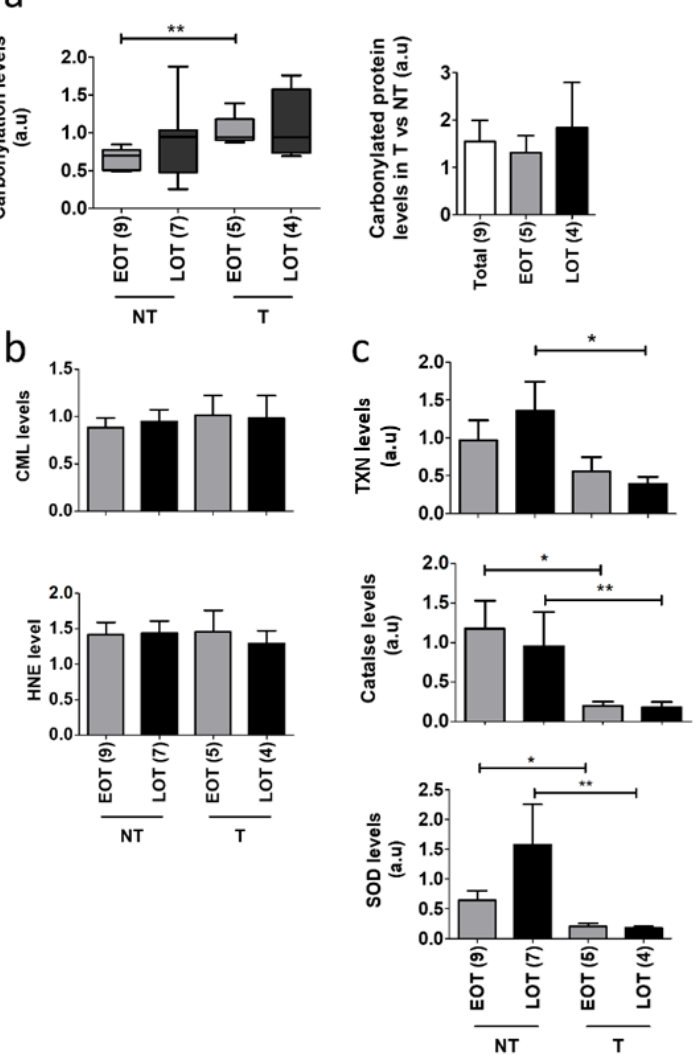
Figure 3. Oxidative stress damages in EOT vs. LOT. ( a ) Left panel: In-gel analysis of total protein carbonylation levels of non-tumor (NT) and tumor tissues (T) from early-onset patients (EOP) and late-onset patients (LOP) normalized by total protein input. Right panel: carbonylated protein rates of T compared to NT in EOP and LOP. Representative in-gel protein deposits are displayed in Figure S5a; ( b ) N(6)-Carboxyl-methyl-lysine (CML) and 4-Hydroxynonenal (HNE) levels quantified by Western blot and normalized by total protein expression (“stain-free” Biorad ® technology). Repre- sentative stain-free membranes, HNE, and CML Western blots are displayed in Figure S5b,c, ( c )